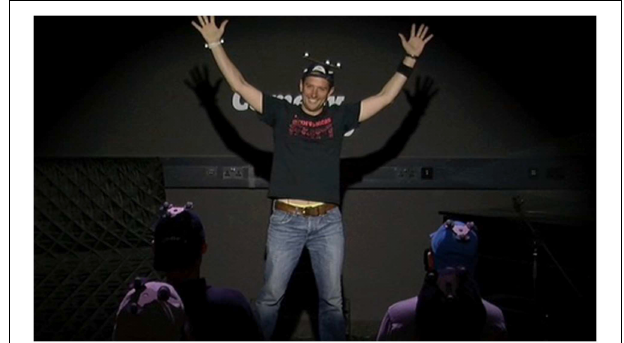
FIGURE 1 | Comedy Lab with Stuart Goldsmith, at Queen Mary University of